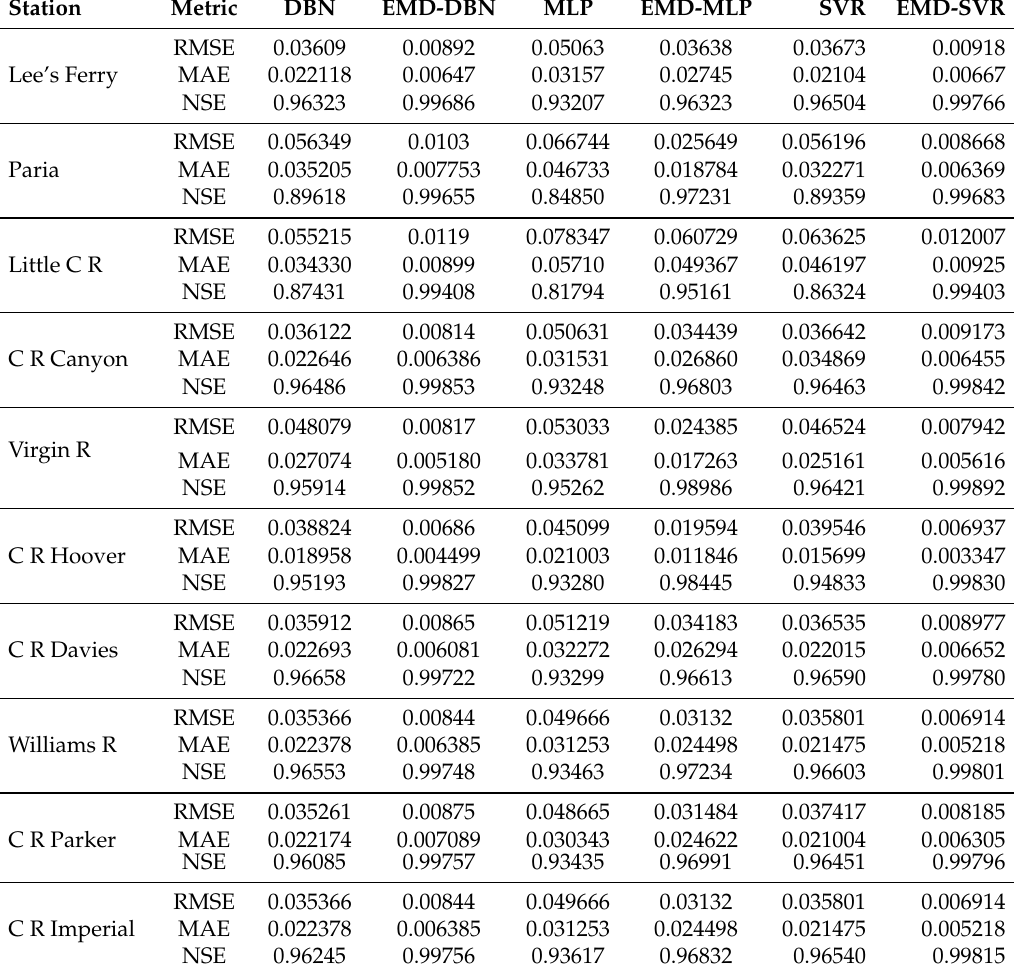
Table 1. Model results: one-step-ahead